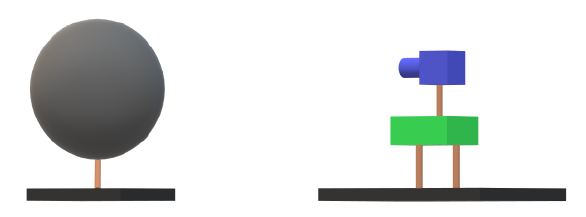
Figure 1. The schematic of the equipment used in our research Then, these images were taken as the input data to compute correspondences, i.e., image matching. Figure 2 shows the flow of this part. We detected features in each image by using SIFT algorithm (Lowe, 2004) and matched keypoints between each pair of images. For each pair, we estimate a fundamental matrix and refine matches by using Random Sample Consensus (RANSAC) algorithm (Nister, 2008). After all pairwise matches are determined, we input correspondences into SfM part.